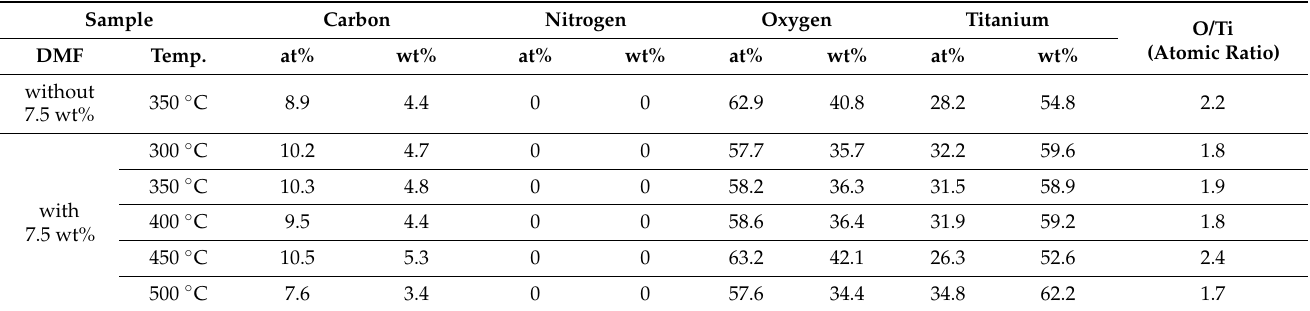
Table 3. The concentration of the carbon and nitrogen of the 350 ◦ C-annealed samples with and without the 7.5 wt% DMF